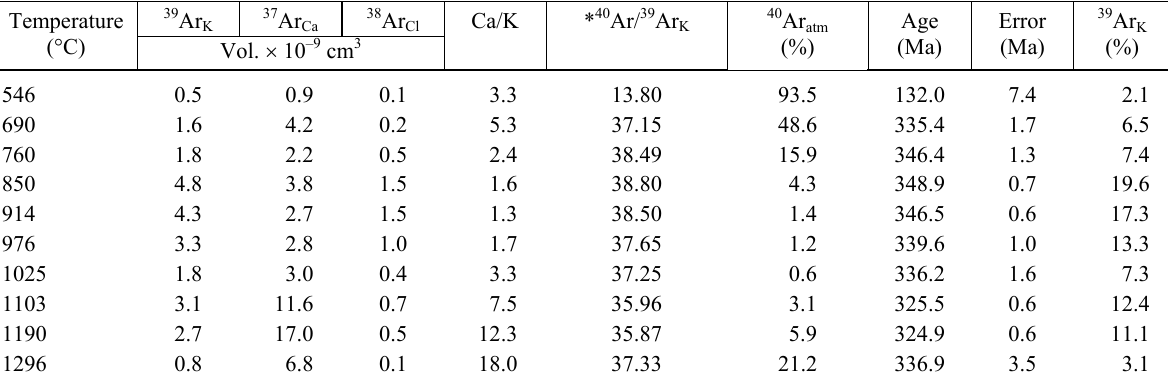
Table 1. 40 Ar/ 39 Ar data of step-heating dating of leached whole-rock dolerite sample D1-1 1/84 (MS10, Leeds University, Leeds run number 2483). Errors quoted on 1-sigma level. * 40 Ar = volume of radiogenic 40 Ar, gas volumes corrected to standard temperature and pressure. Sample grain size 170–250 μ m, sample weight = 0.05302 g, K = 1.2 wt%. No plateau age could